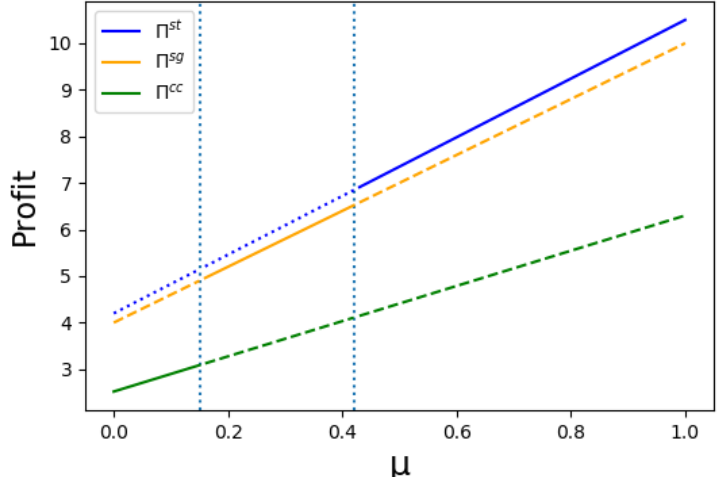
Figure 4. The steady state profits versus the Coase conjecture